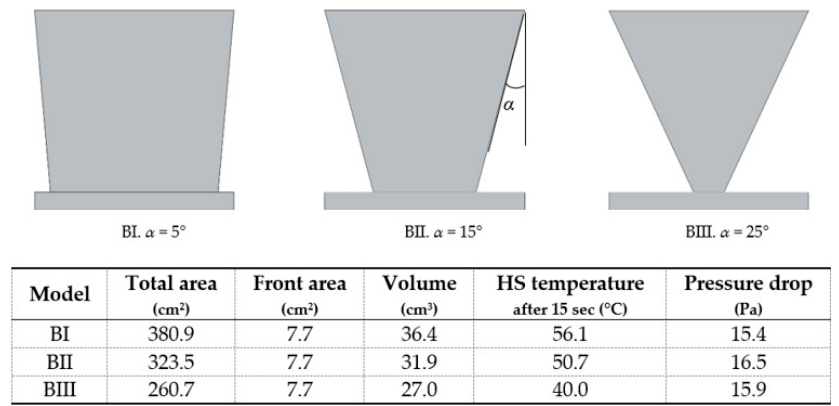
Figure 8. Model B variants.